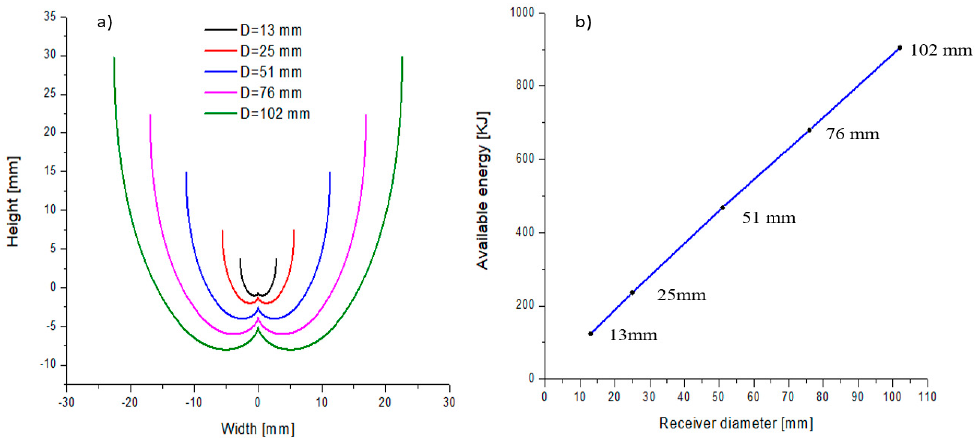
Figure 1. ( a ) 13, 25, 51, and 102 mm, nominal diameters of Compound Parabolic Concentrator (CPC) profiles; ( b ) Available energy vs. receiver diameter.